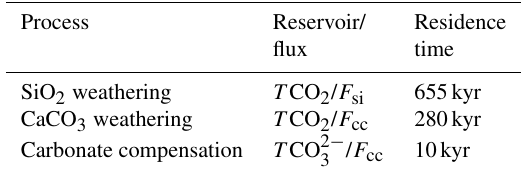
Table 2. Calculated residence times of the main carbon cycle pro-